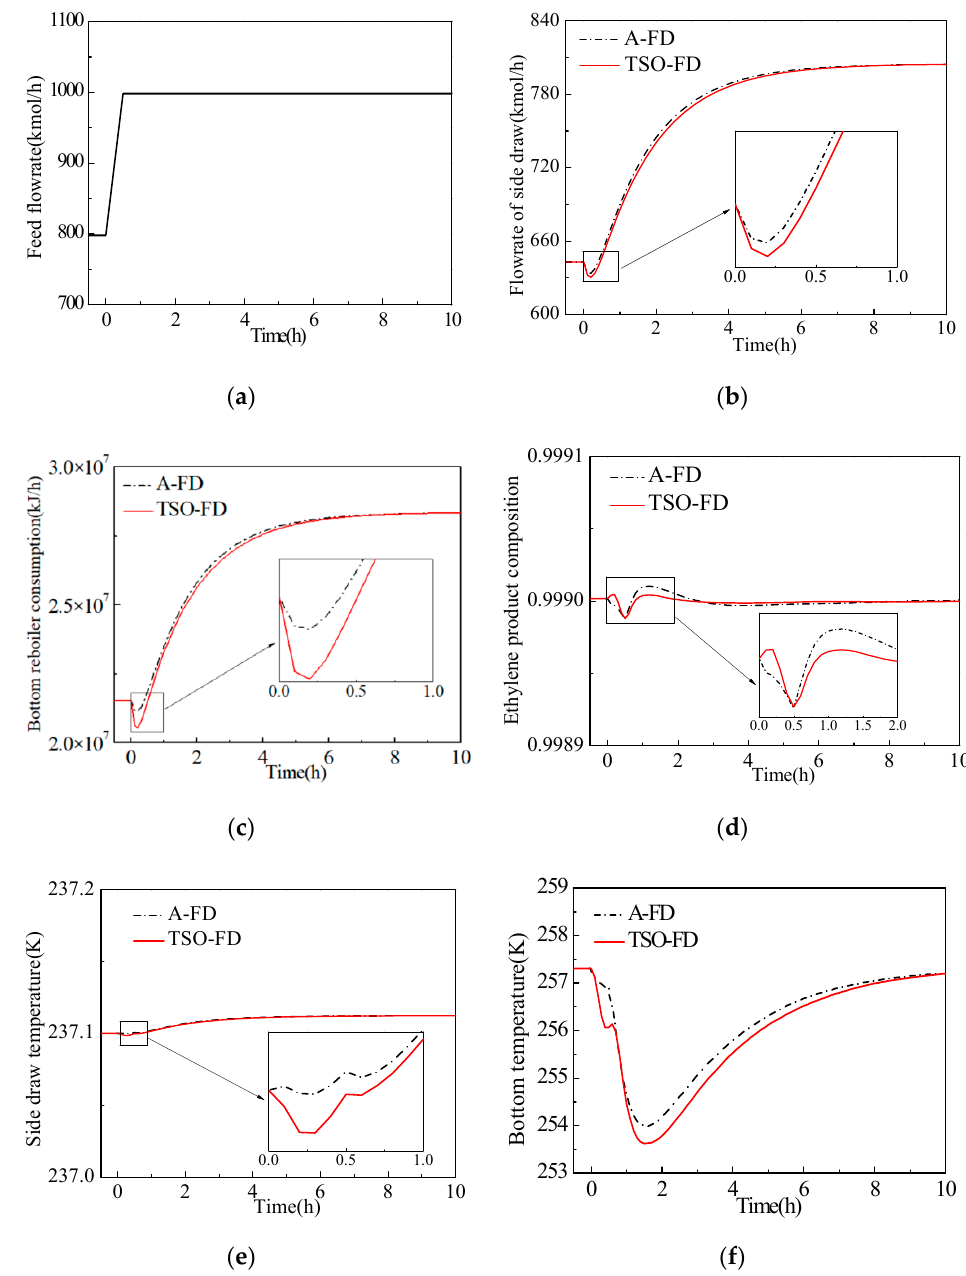
Figure 4. Transition results of the continuous process transition strategy for the ethylene column: ( a ) feed flowrate; ( b ) side draw flowrate; ( c ) bottom reboiler consumption; ( d ) ethylene product quality; ( e ) side draw temperature; ( f ) bottom temperature.